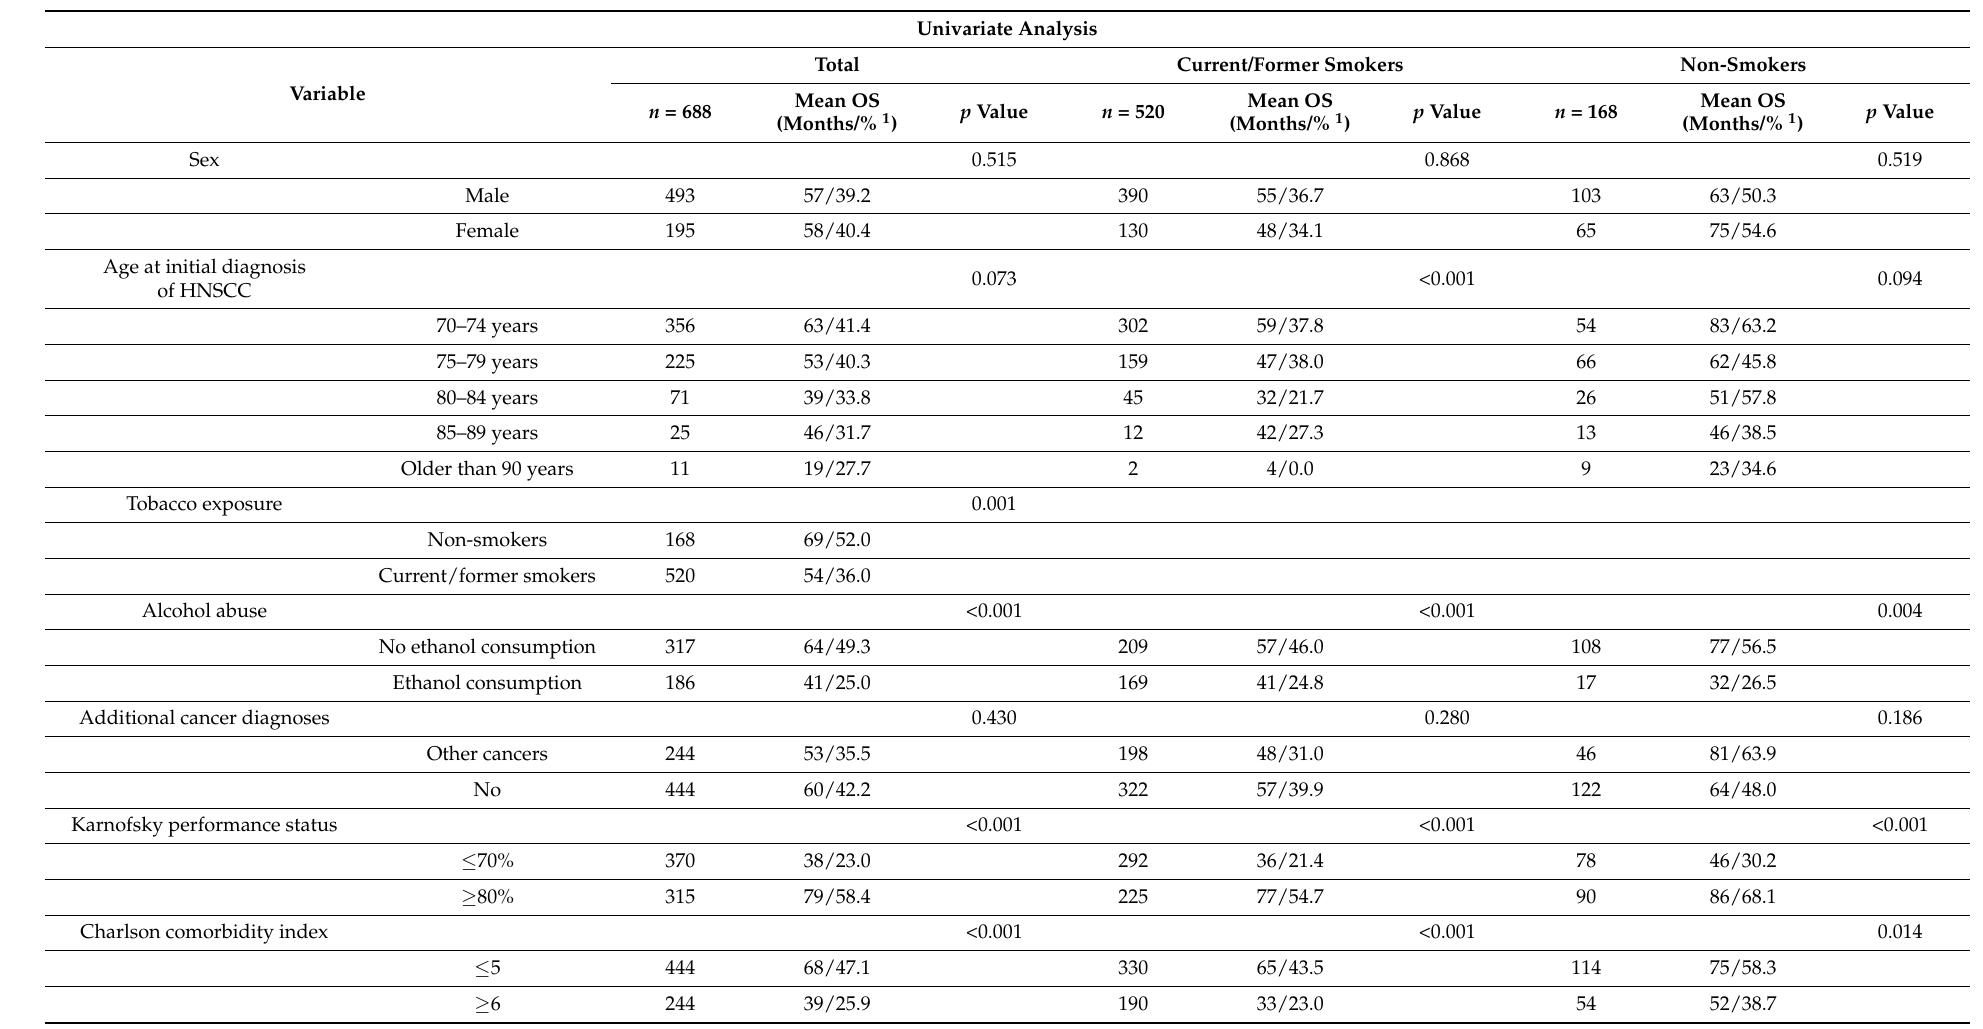
Table 3. Univariate analysis of clinicopathologic variables associated with overall